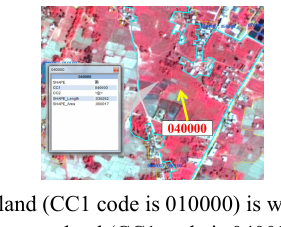
Figure 9 . Shrubs (CC2 code is 020200) are misclassified as arbors (CC2 code is 020100).